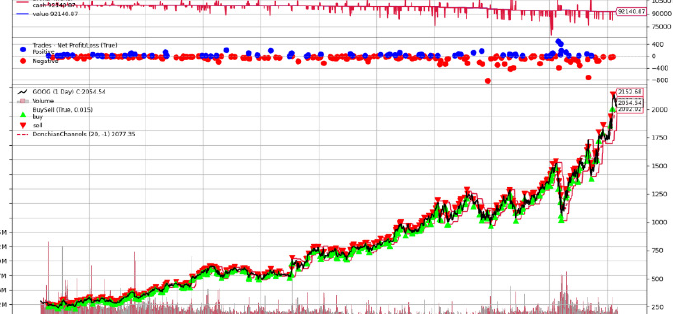
Figure 18: Donchian Back testing